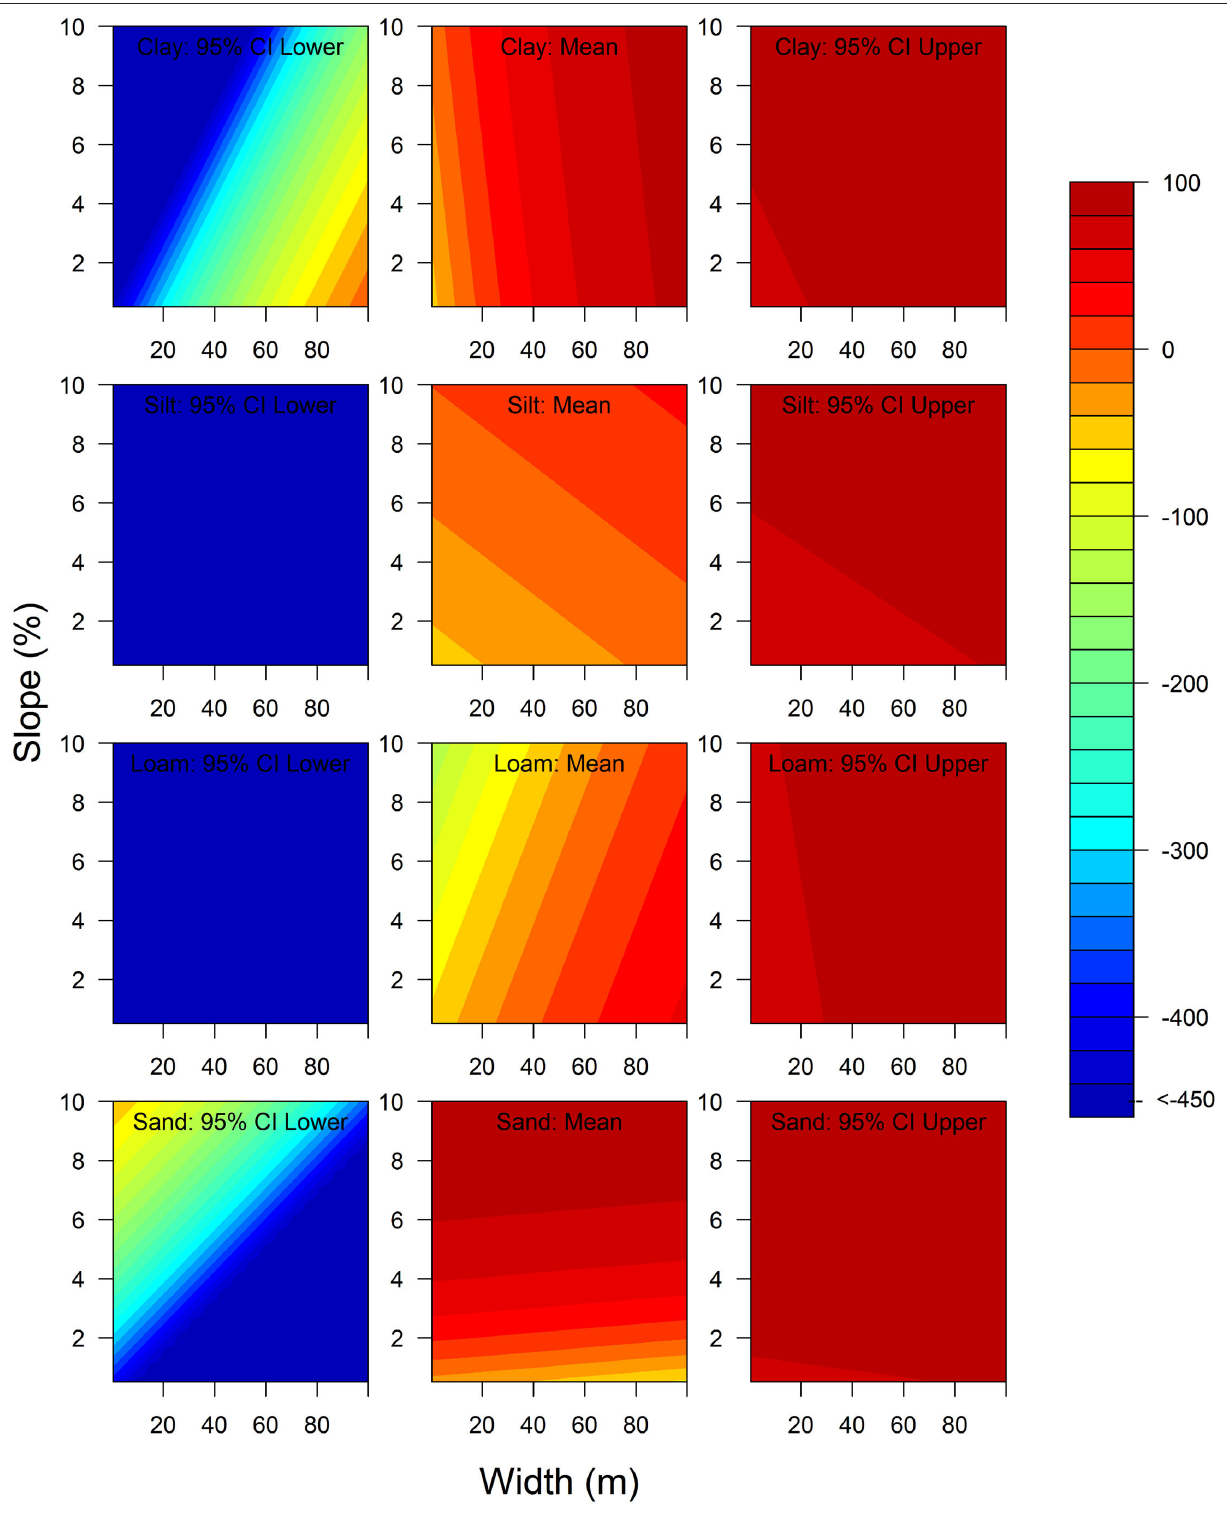
Frontiers in Water |